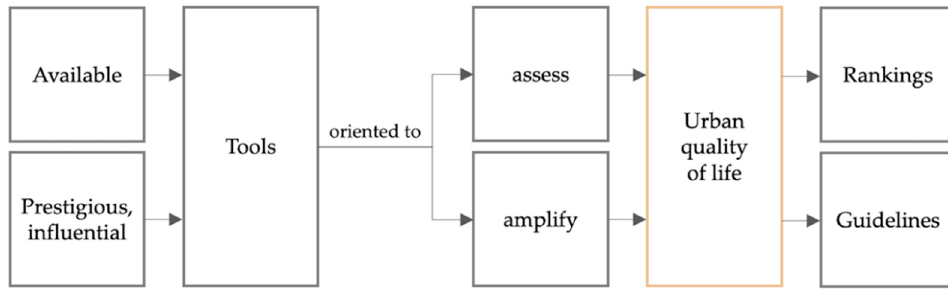
Figure 1. Scheme on the research design: criteria applied for the tools selection. Table 1. Selected appraisal instruments: guides and rankings. Contracting authorities. Table